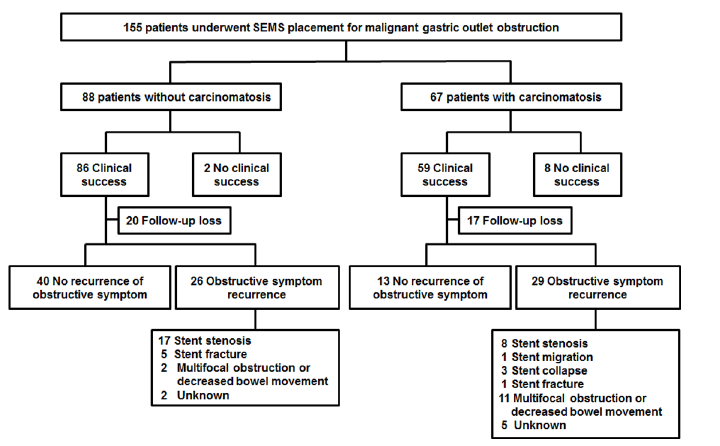
Fig 1. Flow chart of patients.